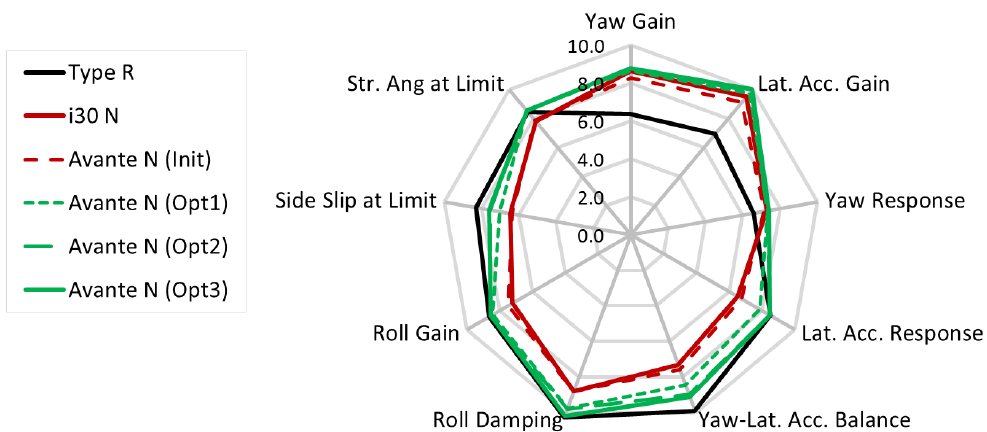
Figure 11. Optimizing handling performance (steering input).